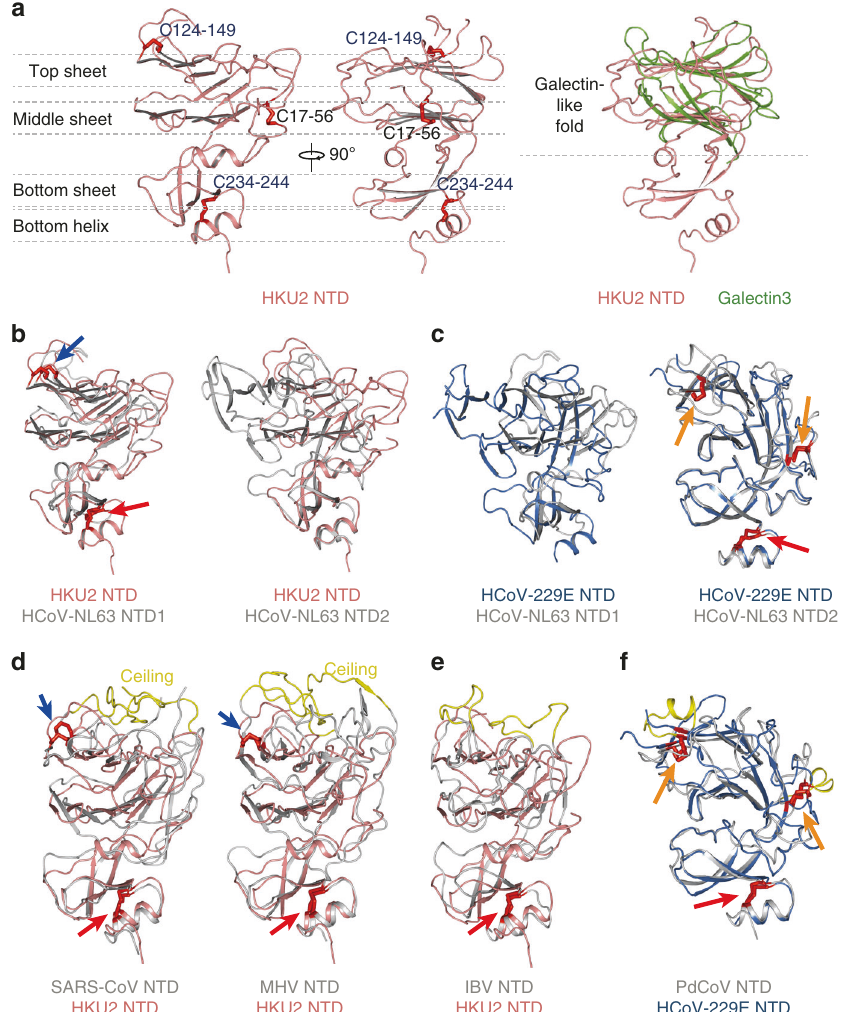
Fig. 2 Structure of HKU2 NTD and comparisons. a Structure of HKU2 NTD. Side views of HKU2 NTD are shown in two orthogonal directions. Disul fi de bonds are shown as red sticks. Conserved disul fi de bonds are labeled blue; other disul fi de bonds are labeled black. Top sheet, middle sheet, bottom sheet, and bottom helix are partitioned by gray dashed lines. Comparison of HKU2 NTD and galectin3 are shown in the right panel. HKU2 NTD is colored salmon; galectin3 is colored green. PDB code: galectin3, 1A3K. b Subtype I NTD of α -coronavirus. Structural alignments of HKU2 NTD with HCoV-NL63 NTD1, and with HCoV-NL63 NTD2 are shown. HKU2 NTD is colored salmon. HCoV-NL63 NTD1 and NTD2 are colored gray. Disul fi de bonds are shown as red sticks. Disul fi de bonds conserved in both types of NTDs are indicated by red arrows; disul fi de bonds conserved in subtype I NTD are indicated by blue arrows; PDB code: HCoV-NL63, 5SZS. c Subtype II NTD of α -coronavirus. Structural alignments of HCoV-229E NTD with HCoV-NL63 NTD1, and with HCoV-NL63 NTD2 are shown. HCoV-229E NTD is colored marine. HCoV-NL63 NTD1 and NTD2 are colored gray. Disul fi de bonds conserved in both types of NTDs are indicated by red arrows; disul fi de bonds conserved in subtype II NTD are indicated by orange arrows. PDB codes: HCoV-229E, 6U7H. d β -coronavirus NTDs resemble subtype I. Structural alignments of HKU2 NTD with SARS-CoV NTD, and with MHV NTD are shown. Disul fi de bonds are shown and labeled the same as in b . Ceilings in β -coronavirus NTDs are shown in yellow. PDB codes: SARS, 5XLR; MHV, 3JCL. e γ -coronavirus IBV NTD resembles subtype I. Structural alignment of HKU2 NTD with IBV NTD is shown. Disul fi de bonds are shown and labeled the same as in b . The additional loops in IBV NTD is shown in yellow. PDB code: IBV, 6CV0. f δ -coronavirus PdCoV NTD resembles subtype II. Structural alignment of HCoV-229E NTD with